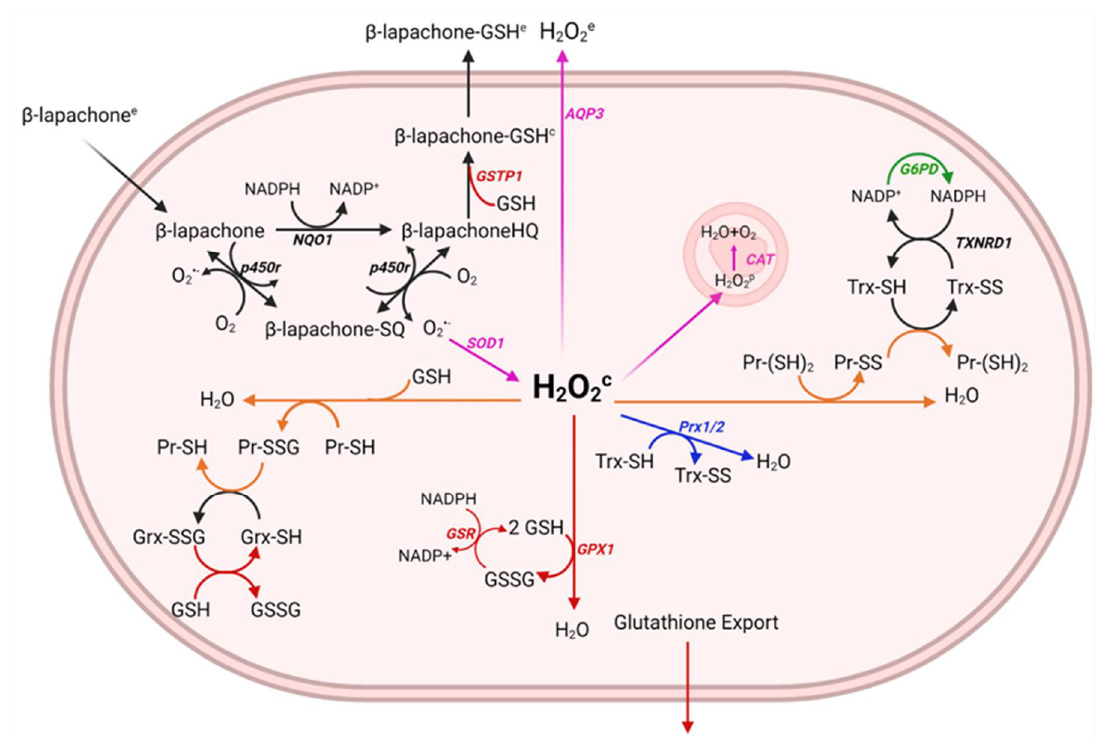
Figure 1. Generation of a relevant model of drug metabolism and hydrogen peroxide clearance pathways. The metabolism of β-lapachone by NQO1 results in the generation of superoxide (O 2•− ) and the oxidation of NADPH. Superoxide dismutase 1 (SOD1) in the cytosol converts the superoxide to hydrogen peroxide (H 2 O 2 ) which is converted to water and oxygen by antioxidant systems including the peroxiredoxin/thioredoxin/thioredoxin reductase/sulfiredoxin system, the glutathione peroxidase/glutathione/glutathione reductase system, catalase, and the oxidation of free protein thiols. NADPH often serves as the reductant for cycling these antioxidant enzymes and is used to reduce β-lapachone, thus, canonical metabolic reactions involved in the production of NADPH are also included, such as glucose−6-phosphate-dehydrogenase (G6PD). Intermediate protein oxidation steps not shown in the diagram.